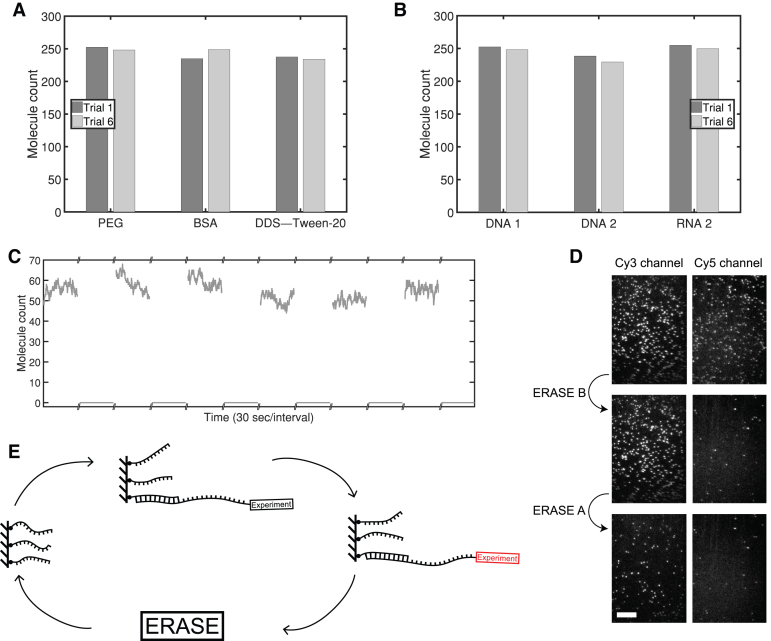
ERASE is versatile. (A) Molecule counts are repeatable and consistent across three different surface passivation techniques: PEGylation, BSA, and DDS–Tween-20 + BSA. (B) ERASE is highly modifiable and can be constructed with any sequence demanded by the experiment. The molecule counts of a different anchor-tether-switch scheme perform comparably to the first scheme. ERASE is adaptable and can be augmented to different types of nucleic acid. Although it is composed of RNA, the tether molecules can still be entirely removed by the same DNA switch molecules. (C) Molecule counts of 70S ribosome complexes with an RNA tether are plotted, and ERASE efficiently removes all molecules. Molecule counts over the same field of view are consistent across several rounds of ERASE. To allow the surface to reach equilibrium, we waited 12 minutes after adding tether molecules and 5 minutes after adding switch molecules. (D) We designed two different DNA tethers, A and B: A is labeled with Cy3 dye and barcode sequence a, and B with Cy5 dye and barcode sequence b. Both tethers contain a common sequence complementary to the anchor. The Cy3- and Cy5-channel images of the same field of view are shown on the left and right columns, respectively. The first row of images are obtained after incubating the anchor-coated surface with a 1:1 mixture of A and B, the second row after ERASE with switch \documentclass[12pt]{minimal}
\usepackage{amsmath}
\usepackage{wasysym}
\usepackage{amsfonts}
\usepackage{amssymb}
\usepackage{amsbsy}
\usepackage{upgreek}
\usepackage{mathrsfs}
\setlength{\oddsidemargin}{-69pt}
\begin{document}
}{}$\bar{\text{{B}}}$\end{document}, which is complementary to B, and the third row after ERASE with switch \documentclass[12pt]{minimal}
\usepackage{amsmath}
\usepackage{wasysym}
\usepackage{amsfonts}
\usepackage{amssymb}
\usepackage{amsbsy}
\usepackage{upgreek}
\usepackage{mathrsfs}
\setlength{\oddsidemargin}{-69pt}
\begin{document}
}{}$\bar{\text{{A}}}$\end{document}, which is complementary to A. To minimize signal loss from the corresponding channel, we introduced switch molecules at a lower concentration which decreased ERASE efficiency. The scale bar is 10 μm. (E) ERASE is generalizable to any experiment using a nucleic acid tether. The tether-containing molecule can undergo irreversible changes (red) such as protein modification or annealing; however, provided the toehold remains intact, the switch molecule can always remove the tether-containing molecule. All presented data is collected from a single flow cell.